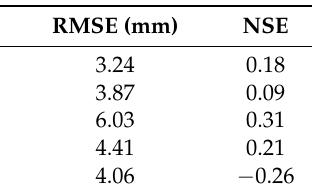
Figure 6. Bias (simulated ‐ observed) of the NARX ‐ and SM2RAIN ‐ modeled rainfall for the 5 KRB stations. 4. Conclusions In this study, the recently developed SM2RAIN algorithm [26] and a new NARX neural network model are applied to convert AMSR – E soil moisture data to predict daily rainfall at 5 climate stations